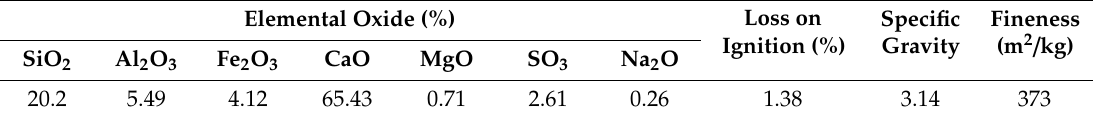
Fineness Specific Ignition (%) (m 2 / kg) Gravity